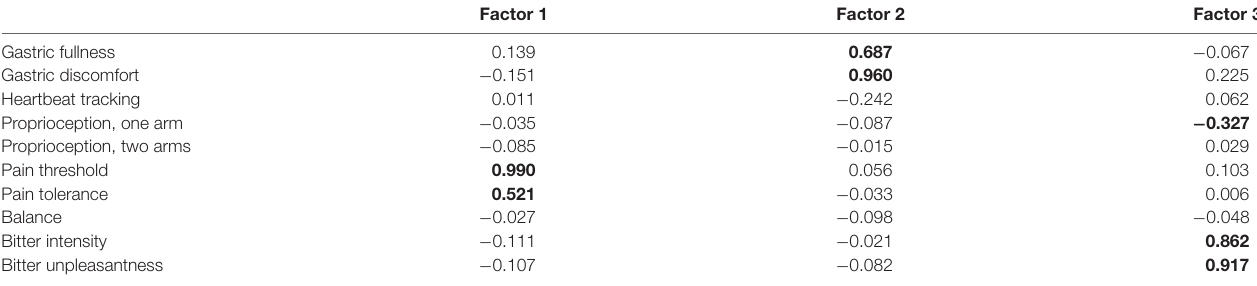
TABLE 3 | Variables’ loadings on the three factors yielded by maximum likelihood (ML) extraction with Oblimin rotation (values larger than 0.3 are marked with